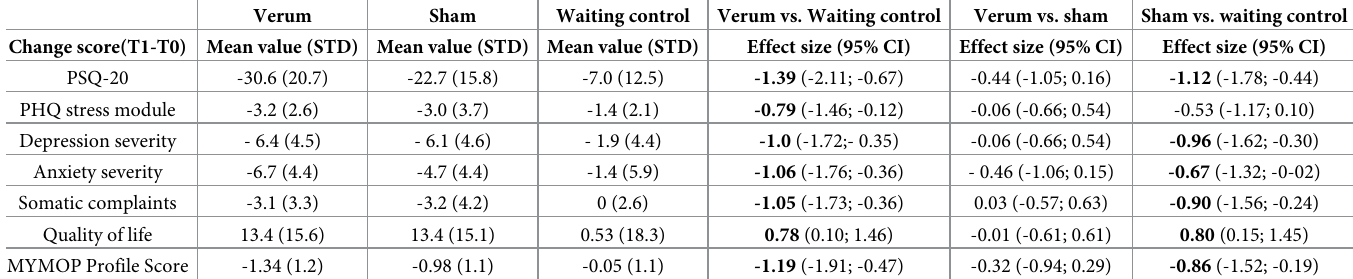
Table 3. Change scores and effect sizes for the PSQ-20 plus additional stress-related variables at T1. Verum Sham Waiting control Verum vs. Waiting control Verum vs. sham Sham vs. waiting